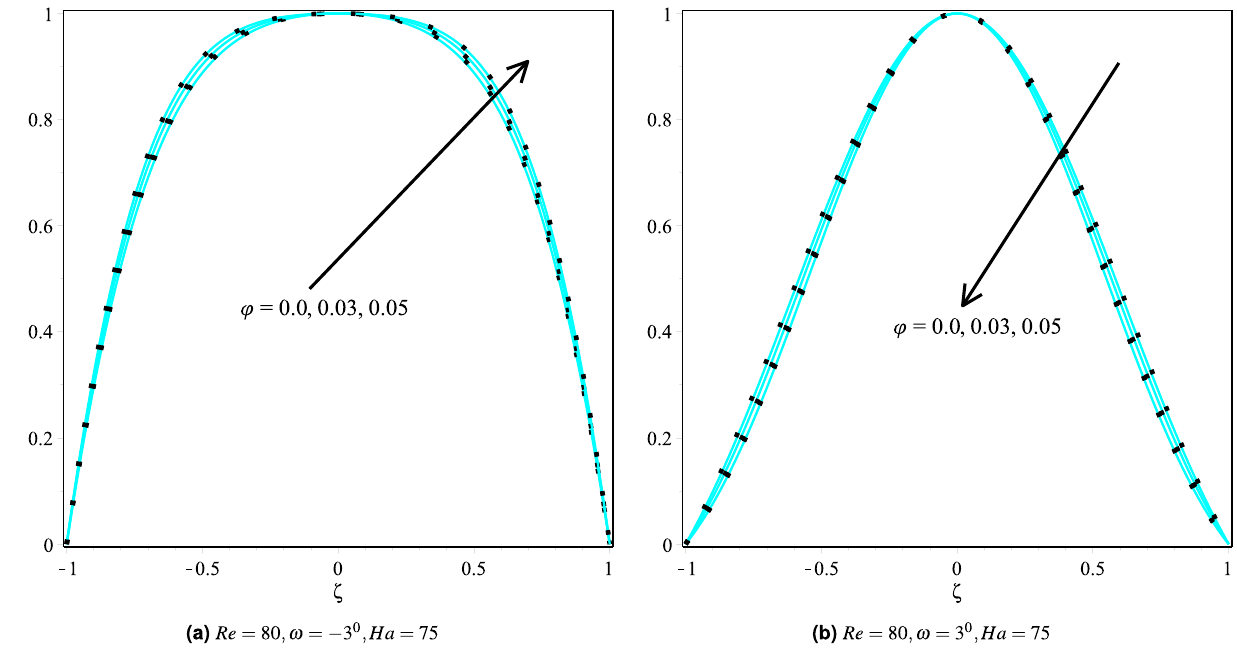
Figure 7. Velocity distribution of the fluid in converging and diverging channel with various φ for Copper-H 2 O and Cu-Al 2 O 3 /H 2 O.